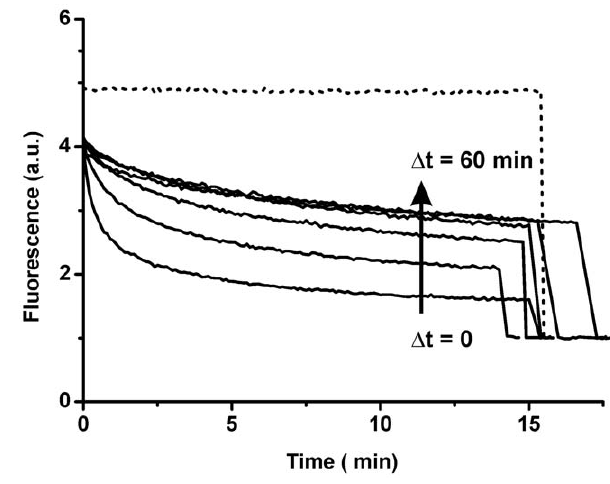
Figure 6. Transient vesicle permeabilization assay. To measure if vesicle permeabilization was transient POPG LUVs encapsulating dextran-PTS were prepared. The quencher DPX was added D t after mixing the vesicles with oligomeric a S to a final concentration of 0.25 mM lipid and 1.5 m M a S. The dotted line is a background curve in the absence of protein. After , 15 minutes Triton X-100 is added to disrupt all vesicles, the curves are normalized to this final value. In the absence of calcium the dextran-PTS conjugate escapes the vesicle interior upon protein interaction (3kDa red lines, 70 kDa blue lines).